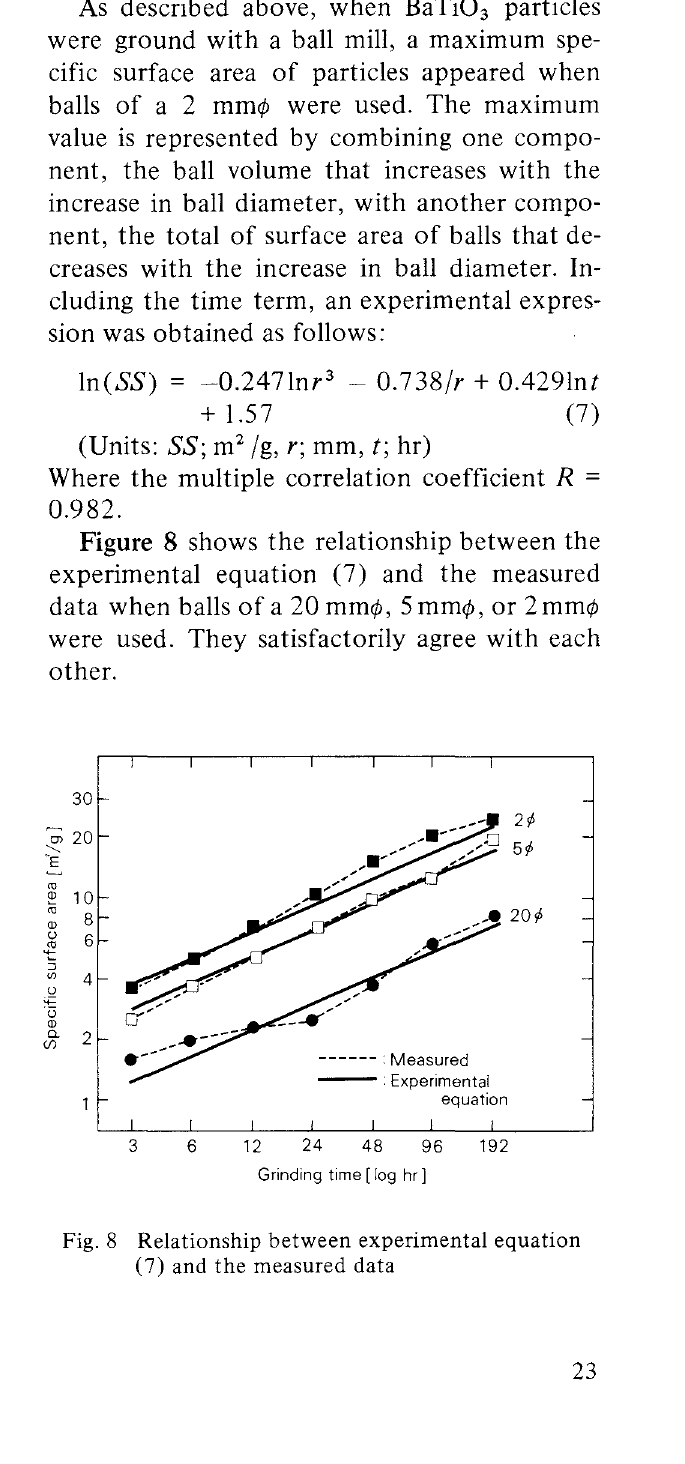
Fig. 8 Relationship between experimental equation (7) and the measured data